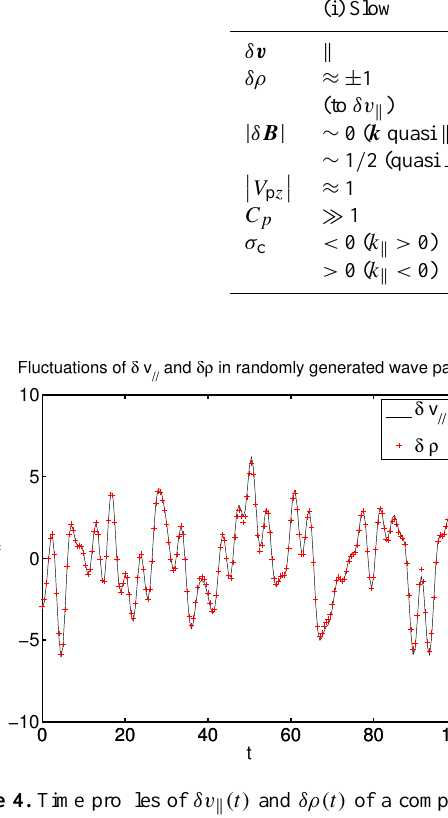
Figure 5. Temporal evolution of quantities near propagating region of slow wave case 1. (a) Temporal profiles of density ρ , with slow wave train displayed. (b) Temporal profiles of z component of ve- locity v z , with the same (z,t) points as shown in (a) . (c) Tempo- ral profiles of d v x / d z , with two secondary wave trains displayed. (d) Distribution of δv z and δρ at points near the slow wave train dis- played in (a) . In (a) to (c) the horizontal axis represents coordinate z in the slice. The vertical axis marks the times of corresponding profiles. The colors plot the corresponding physical quantities. In (d) the blue line plots δρ/δv z = 1 as a reference; colors of mark- ers show their time, with red ones earlier and green ones later. The fluctuation values are obtained by subtraction of the average of the quantities at these